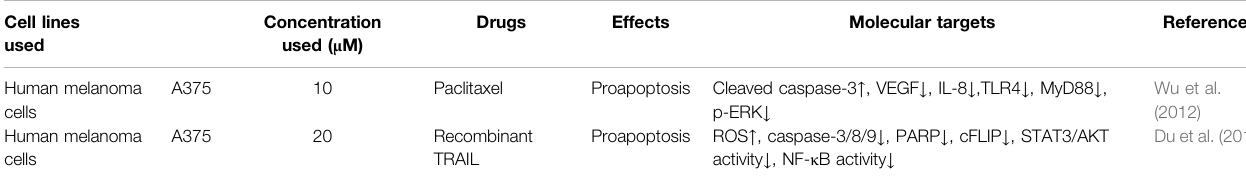
TABLE 2 | Ef fi cacy of Icariside II in combinational cancer therapy. Cell lines